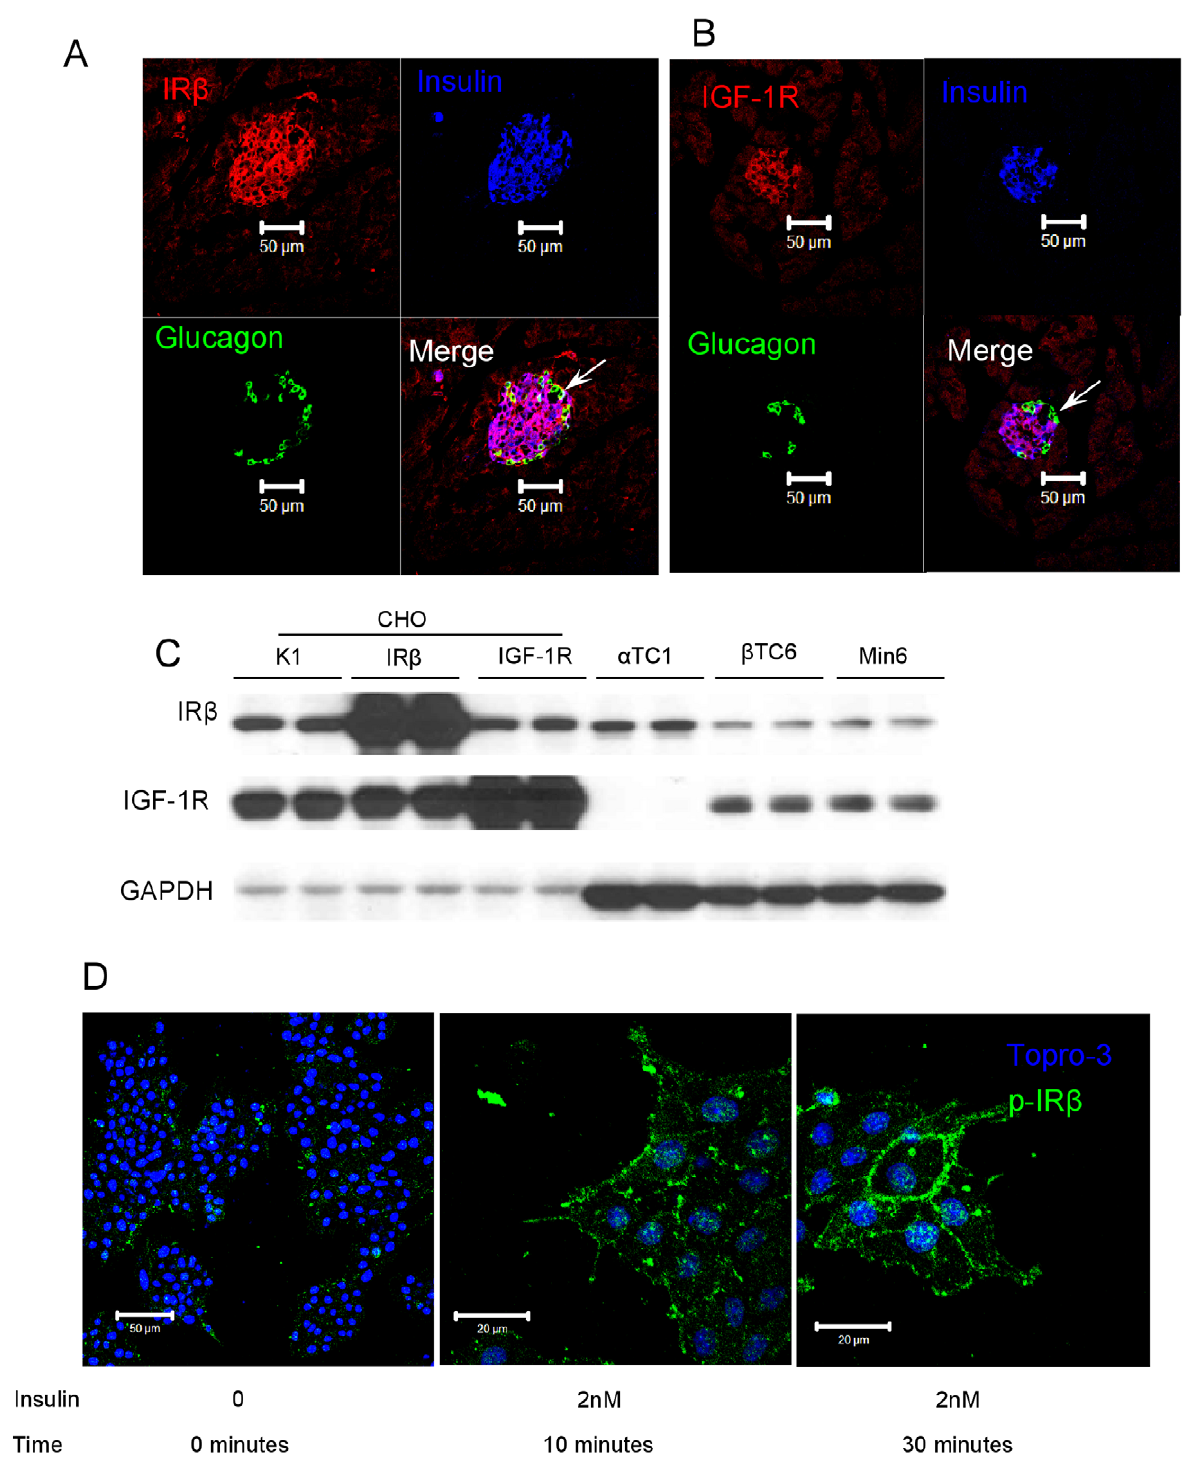
Figure 3. Insulin functions through insulin receptors (IR), not IGF-1 receptors (IGF-1R), in a cells. (A) Immunofluorescent staining of IR b in a pancreatic islet of a mouse. Merge of IR b and glucagon is yellow, demonstrating co-localization in a cells (arrow). (B) Immunofluorescent staining of IGF-1R in a pancreatic islet of a non-diabetic mouse. There is no merge of IGF-1R and glucagon (no yellow), demonstrating lack of co-localization (arrow). IGF-1Rs are present on b cells. (C) Western Blot analysis of insulin receptors (IR b ) and IGF-1R in CHO cells, and a -and b -cell lines. IR b is present in all cell types while IGF-1R is not expressed in a cells (CHO- IR b are transfected with IR, CHO-IGF-1R are transfected with IGF-1R, CHO-K1 are non- transfected). (D) Immunofluorescence staining of phosphorylated insulin receptors (p-IR b ) in a TC1 cells in response to insulin at the times shown.